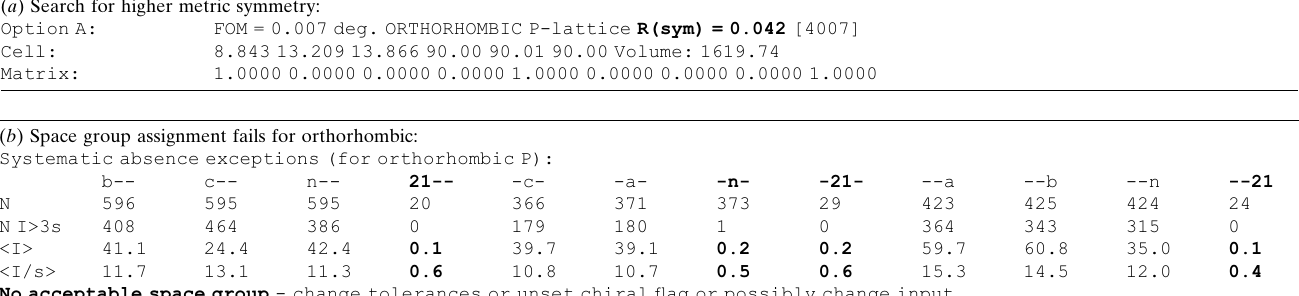
Table 1 Selected annotated output from XPREP for XUBNIR. ( a ) The unit-cell parameters suggest the orthorhombic crystal system. ( b ) Systematic absences are inconsistent with any orthorhombic space group. ( c ) Assignment as monoclinic gives systematic absences consistent with P 2 1 / n . ( a ) Search for higher metric symmetry: Option